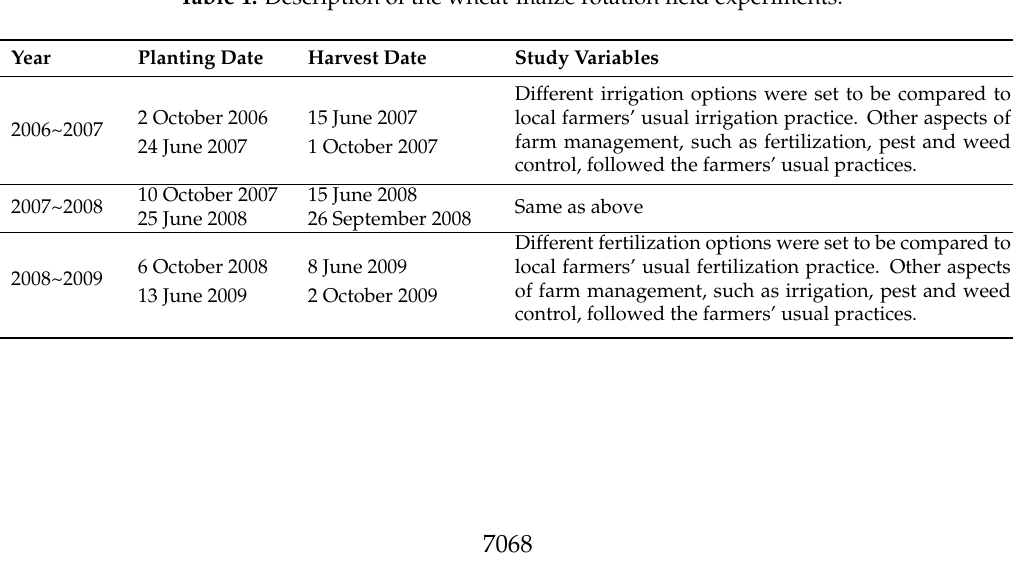
Table 1. Description of the wheat-maize rotation field